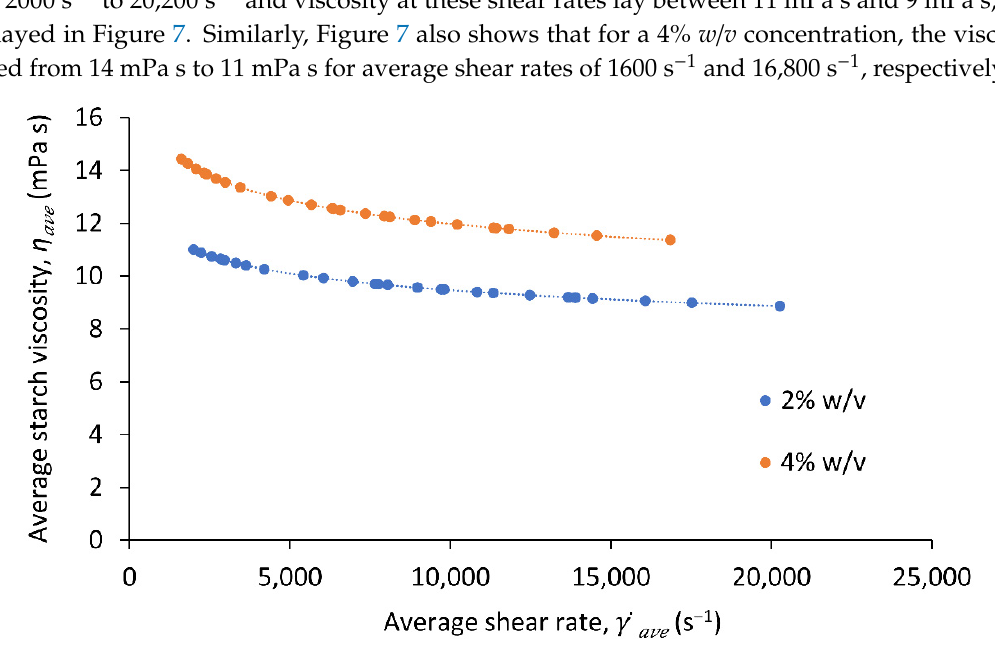
Figure 7. Average estimated viscosities of 2% w / v and 4% w / v starch solutions at varying conditions in the SDR from the power law model for starch using the expression given in Equation (1).